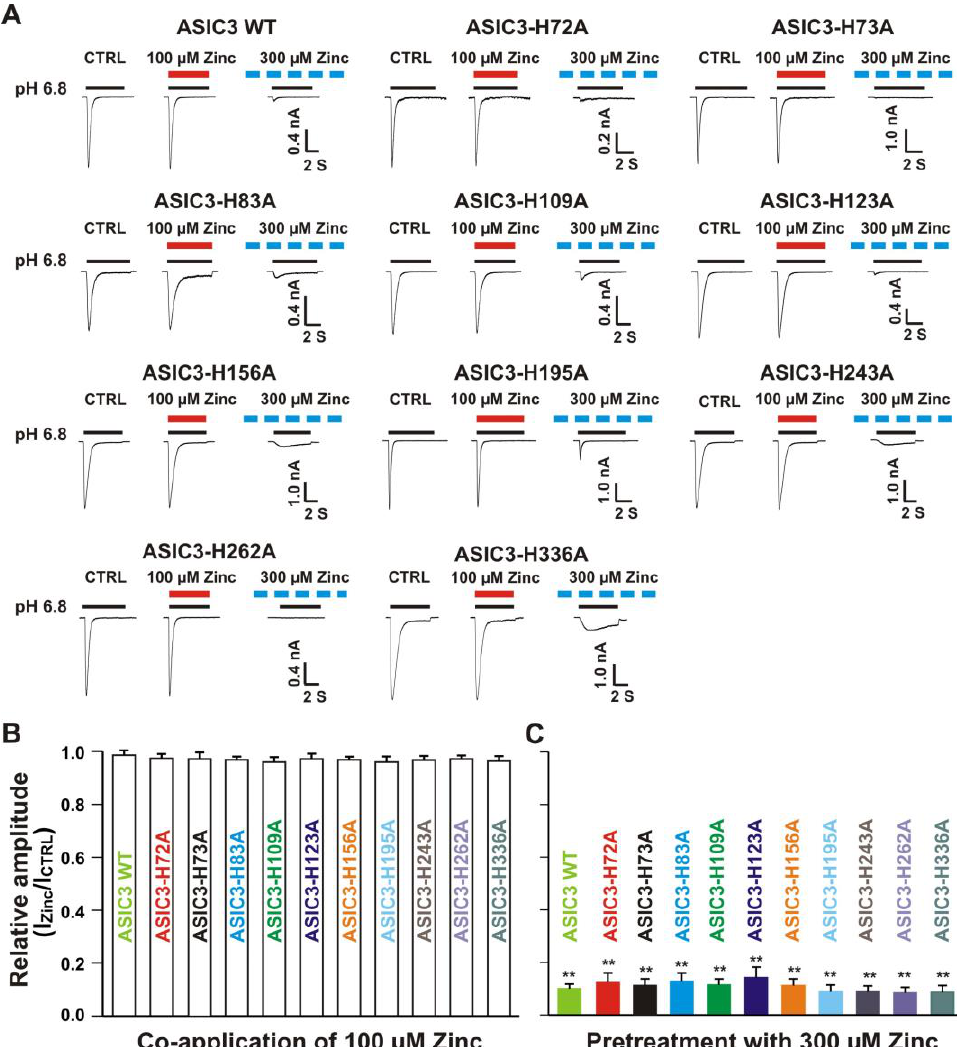
Figure 11. Zinc effects on currents from ASIC3 WT and ASIC3 mutants of histidine residues in the extracellular domain of ASIC3. ( A ) Representative traces show that co-application of zinc at a concentration of 100 µM had no effect on peak amplitude of the currents recorded from ASIC3 WT, ASIC3-H72A, ASIC3-H73A, ASIC3-H83A, ASIC3-H109A, ASIC3-H123A, ASIC3-H156A, ASIC3-H195A, ASIC3-H243A, ASIC3-H262A, and ASIC3-H336A; whereas pretreatment with zinc at a concentration of 300 µM showed profound inhibition on currents from ASIC3 WT, ASIC3-H72A, ASIC3-H73A, ASIC3-H83A, ASIC3-H109A, ASIC3-H123A, ASIC3-H156A, ASIC3-H195A, ASIC3-H243A, ASIC3-H262A, and ASIC3-H336A. The solid red and black lines represent 100 µM zinc and pH 6.8 application, respectively (each recoding with 7 s of zinc and pH 6.8 application). The dashed blue line represents pretreatment with 300 µM zinc in the pH 7.4 solution with a duration of 2 min. ( B and C ) Statistical bar graphs show relative peak amplitudes of the currents by co-application of zinc (B, n = 7 to 10) and pretreatment with zinc on ASIC3 WT and their histidine mutants expressed on CHO cells as mentioned above (C, n = 6 to 10). There was no significant difference on currents by co-application of zinc or pretreatment with zinc (inhibitory effect) among ASIC3 WT and their histidine mutants ( p > 0.05, ANOVA). For ASIC3 mutation, histidine residues in the extracellular domain of ASIC3 were replaced with alanine. Whole-cell patch-clap recording was performed and currents of ASIC3 and its mutants were activated by a drop in pH from 7.4 to 6.8. Data are presented as mean ± SEM. CTRL represents control. I CTRL , ASIC current without any treatment; I Zinc , ASIC current by zinc treatment. ** p < 0.01 (t-test).